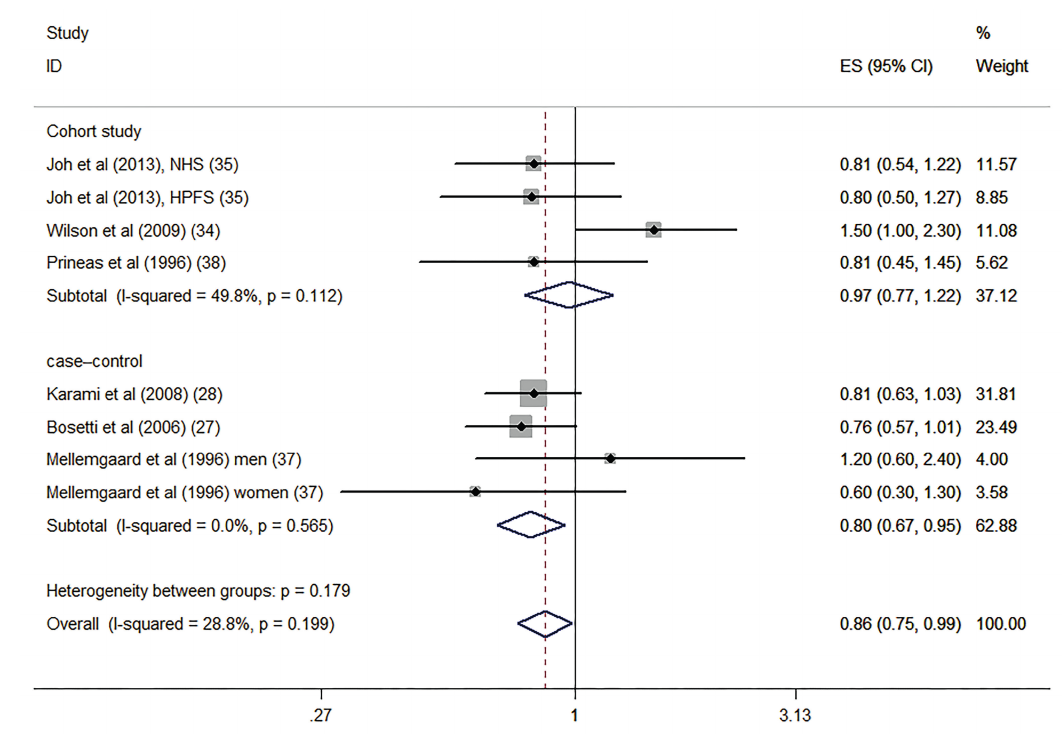
Figure 5 - Subgroup analyses of dietary vitamin D intake and risk of renal cell carcinoma in different study